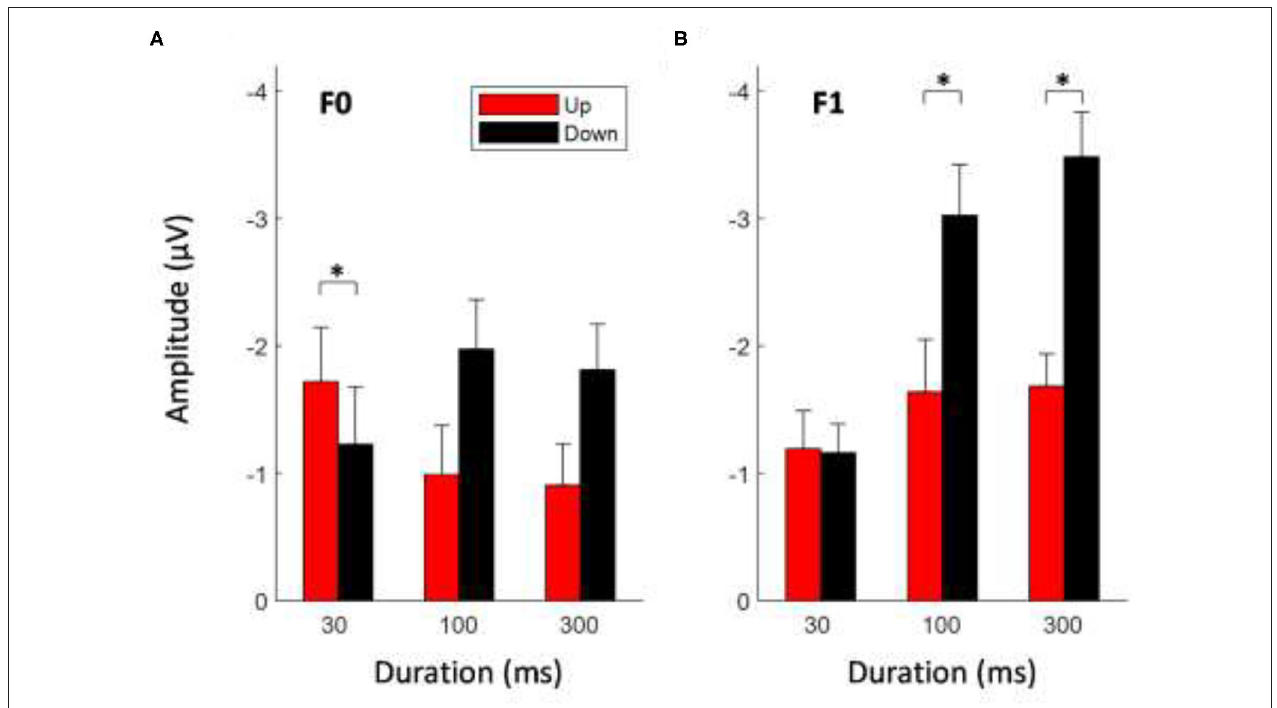
FIGURE 3 | Average MMN mean amplitudes elicited by tone sweeps at different direction and duration for F0 (A) and F1 (B) frequency formant. Error bars indicate ± 1 standard error. *Indicates statistically significant at p < 0.05.